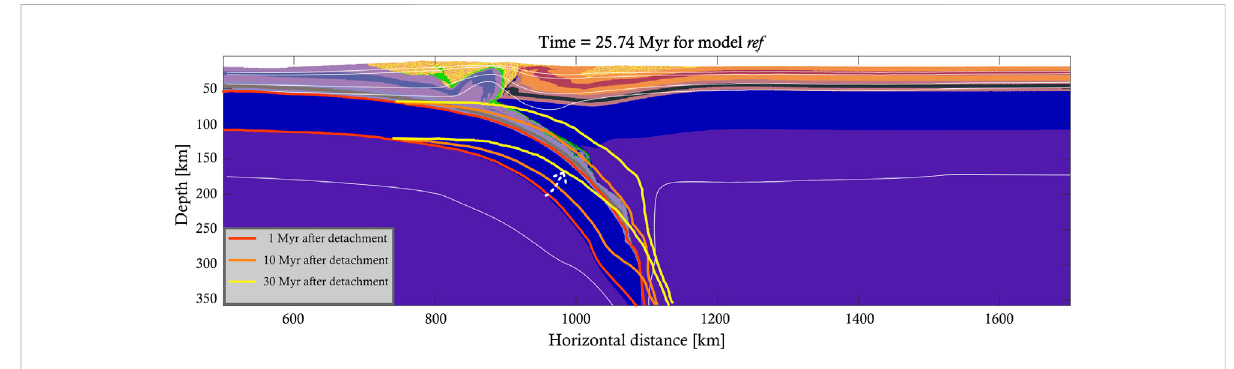
FIGURE 5 Illustration of the post-detachment slab rebound and unbending for the reference model. The slab contours at 1, 10 and 30 Myr after detachment are drawn in red, orange and yellow, respectively. The general slab motion is illustrated with a dashed white